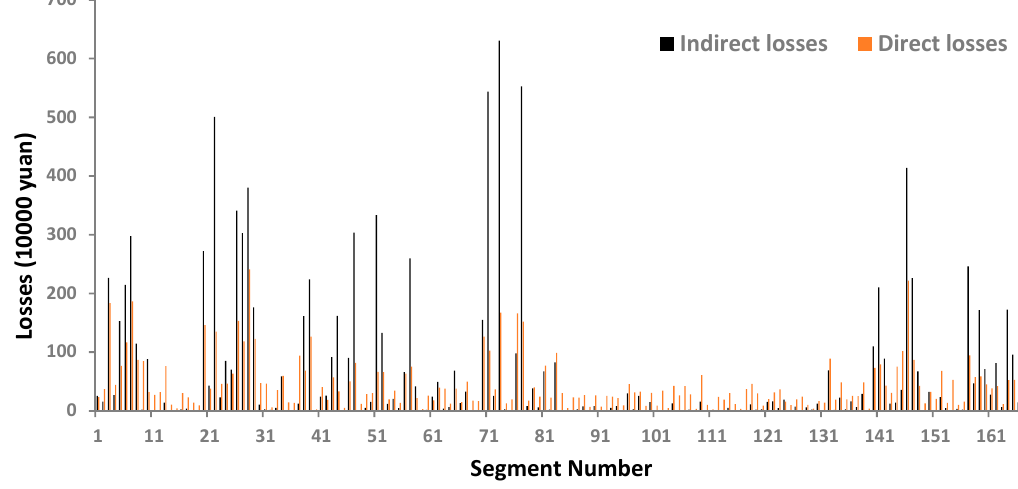
Figure 9. Indirect and direct losses of different segments.